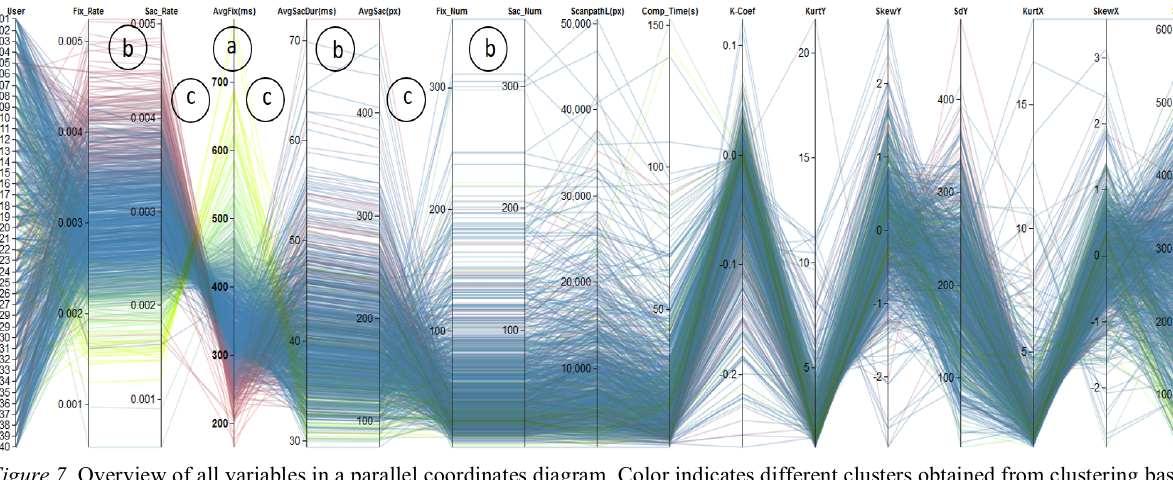
of eight participants with 16 metrics is shown in Figure 6(e).